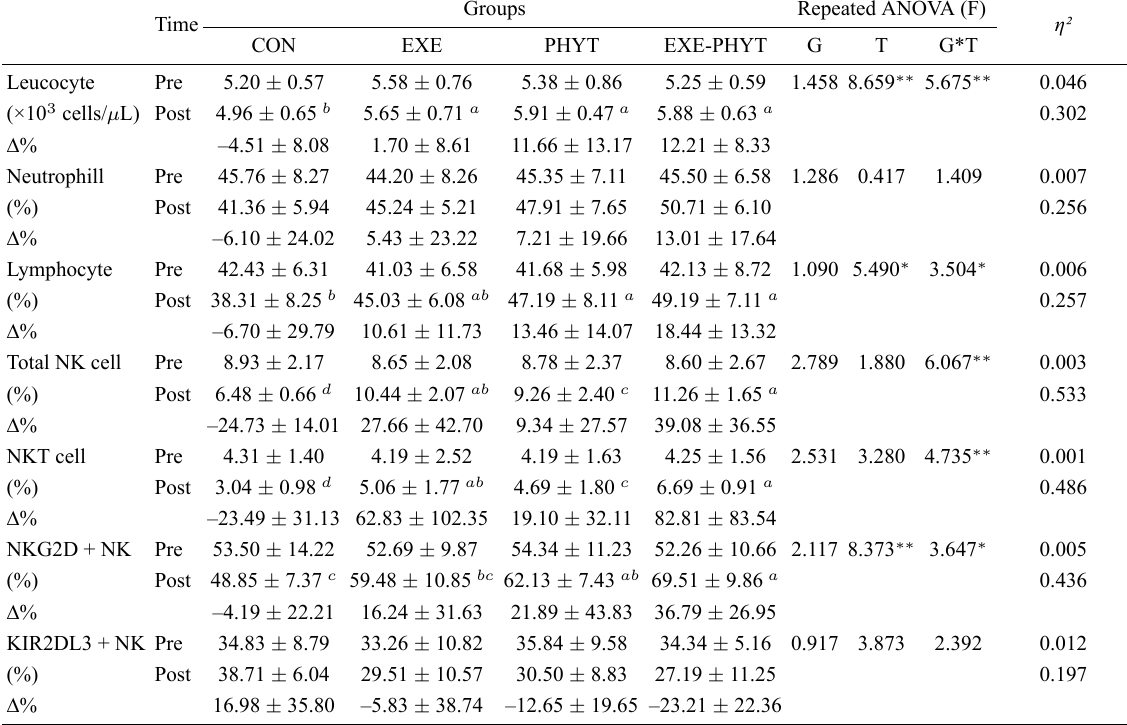
Table 6. Differences and changes in